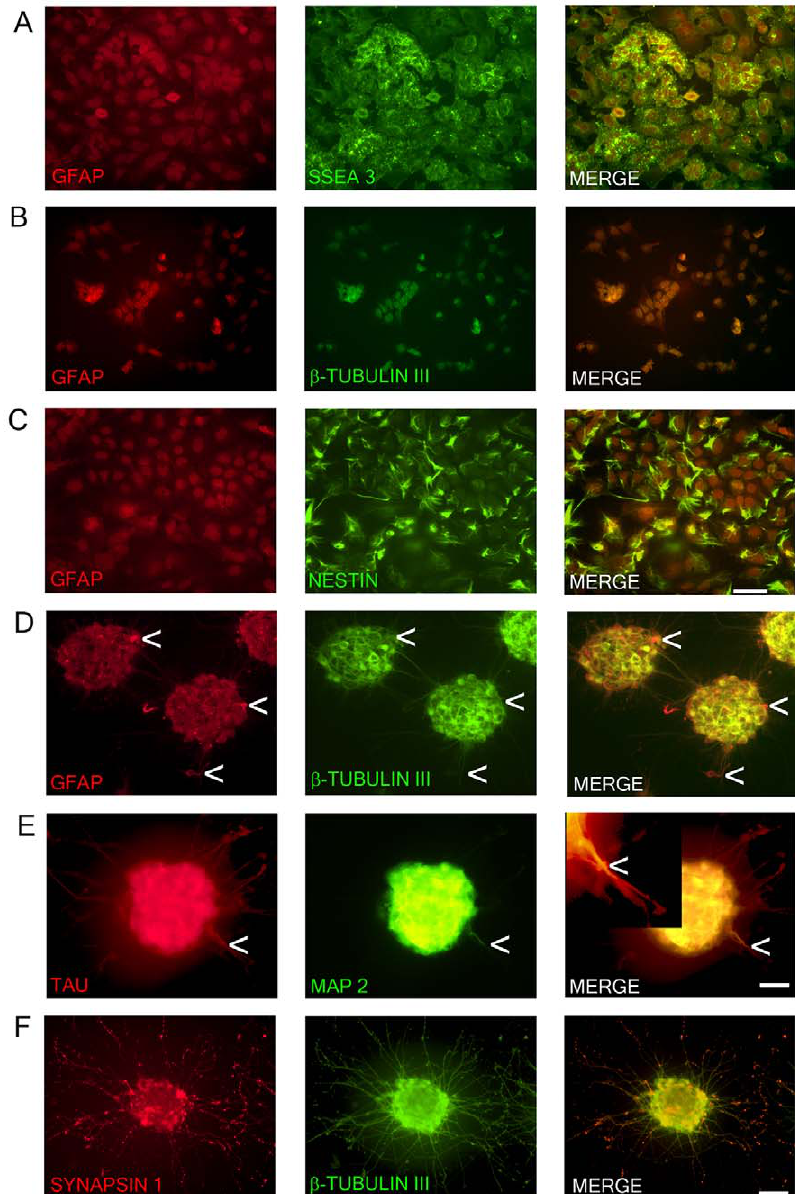
Figure 1. Marker expression of NTERA2 (NT2) cells and ATRA differentiated NTERA2 neurons (NT2N). NT2 cells (A–C) co-express GFAP and SSEA3 with GFAP staining confined to the nucleus (A). NT2 cells also co-express GFAP and b -tubulin III (BT3) which are both mainly confined to the nucleus (B). Nestin with GFAP are co-localized in NT2 cells (C). NT2N assembled themselves into cell clusters which co-expressed GFAP and BT3 found within the cytoplasm and neurites (D). Arrow heads point to cells that appear as radial glia cells which only display GFAP staining (D). NT2N also express neural markers TAU and MAP2 with MAP2 confined to dendrites (tapering morphology shown by arrow heads) and TAU not displaying restriction to axons. In merge panel insert shows close-up view of neurite (E). Synapsin 1 staining is seen as punctate along neurite projections co- expressing BT3 (F). Photomicrographs were obtained at 100X (A–C; scale bar 200 m m) and 200X (D–F; scale bar 100 m m).